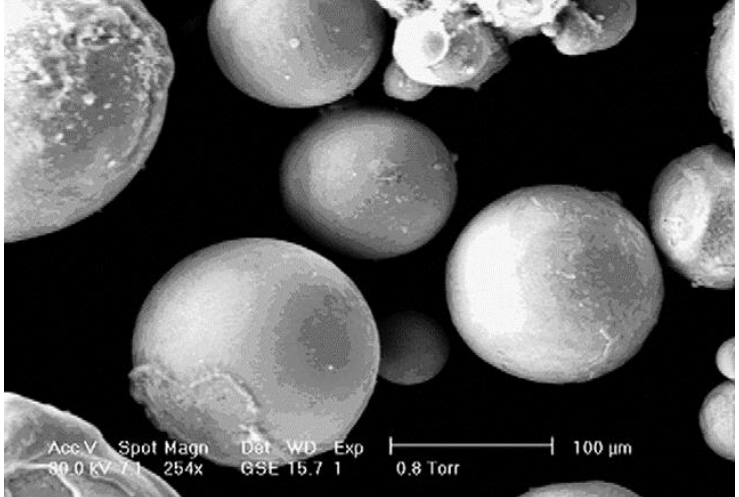
Figure 13. Scanning electron micrograph of particles produced in water at 50 A and 512 ms [170].